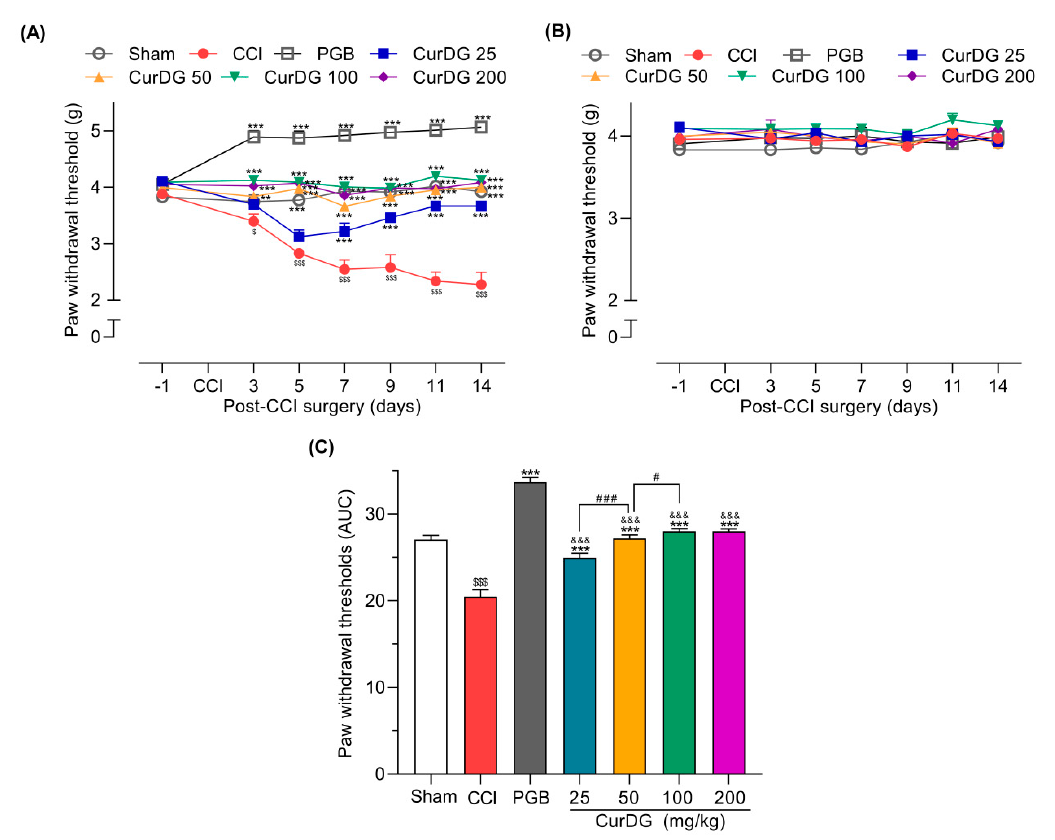
Figure 2. Anti-allodynic e ff ect of CurDG at 25, 50, 100, and 200 mg / kg on the paw withdrawal thresholds (PWT) of ( A ) ipsilateral and ( B ) contralateral paws using von Frey test in chronic constriction injury (CCI)-mice ( n = 8 mice / group). ( C ) Quantification of CurDG analgesic e ff ects using the area under the curve (AUC) of PWT changes over time. ** and *** indicate a significant di ff erence compared to the vehicle-treated group at the levels of p < 0.01 and p < 0.001, respectively. $ p < 0.01 and $$$ p < 0.001 compared to sham group, &&& p < 0.001 compared to pregabalin-treated group (PGB) and # p < 0.05 and ### p < 0.001 compared between successive doses of CurDG.